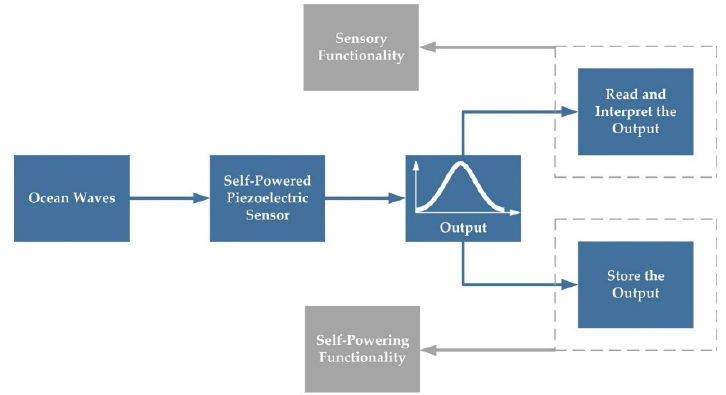
Figure 3. Working principle of the self-powered piezoelectric sensor.